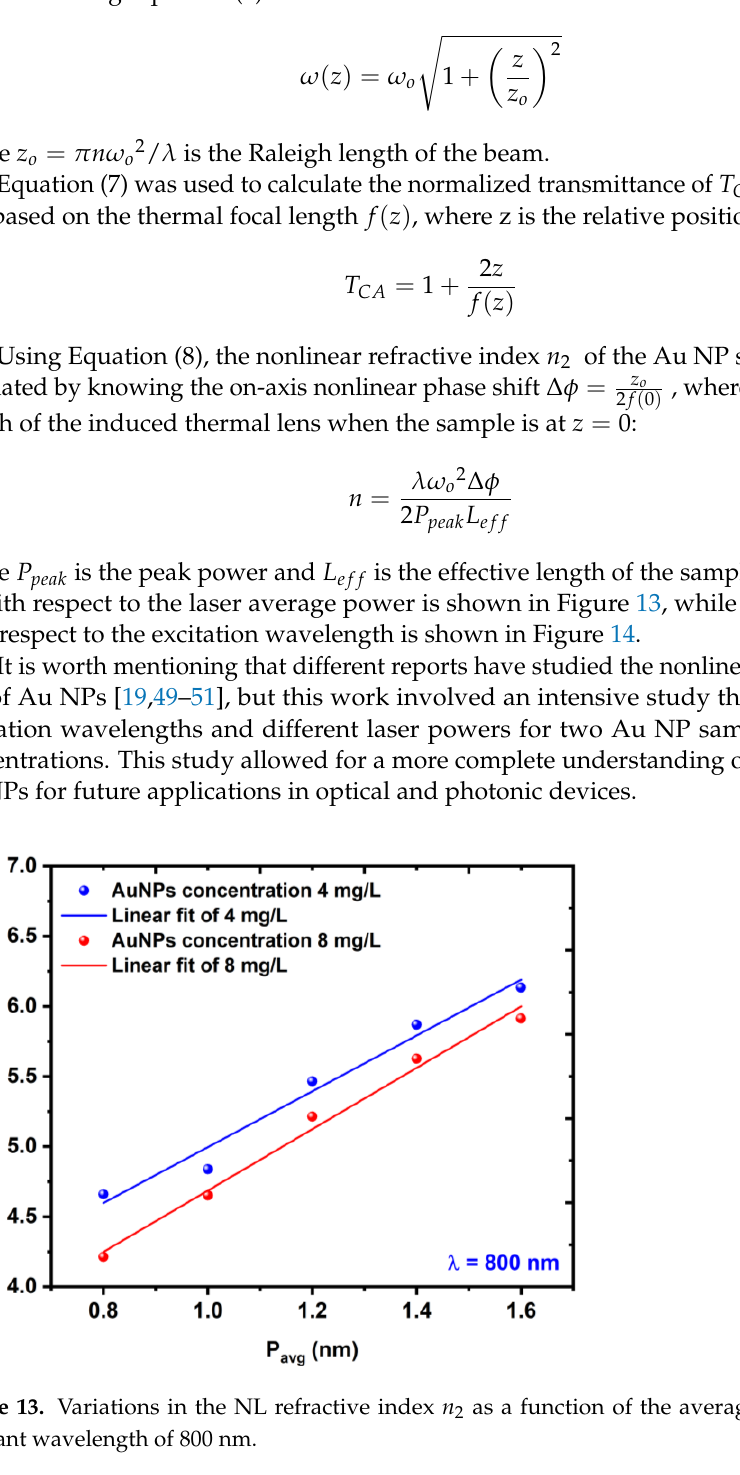
Figure 13. Variations in the NL refractive index 𝑛 2 as a function of the average power 𝑃 𝑎𝑣𝑔 at a constant wavelength of 800 nm.